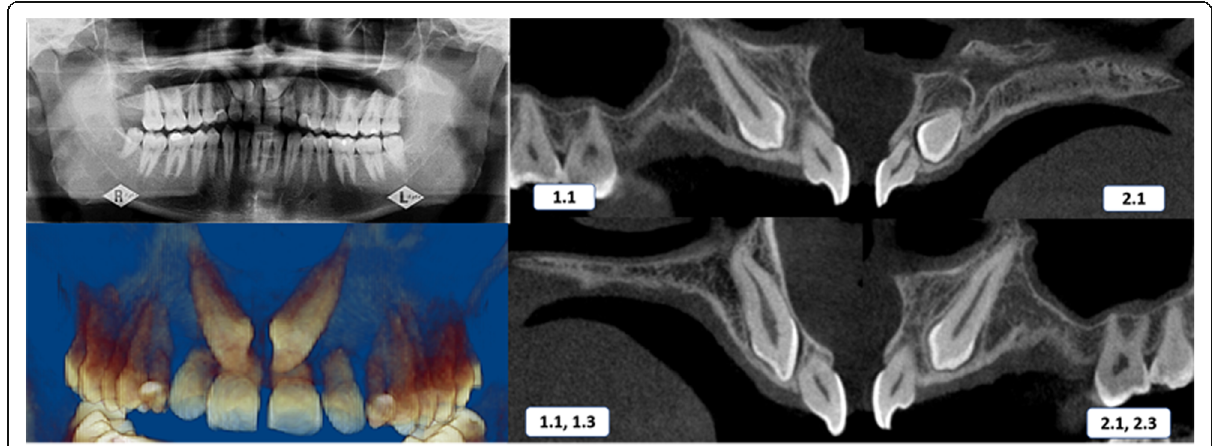
Fig. 2 Initial panoramic radiography and CBCT scans — case 2. 1.1, maxillary right central incisor; 1.3, maxillary right canine; 2.1, maxillary left central incisor; 2.3, maxillary left canine